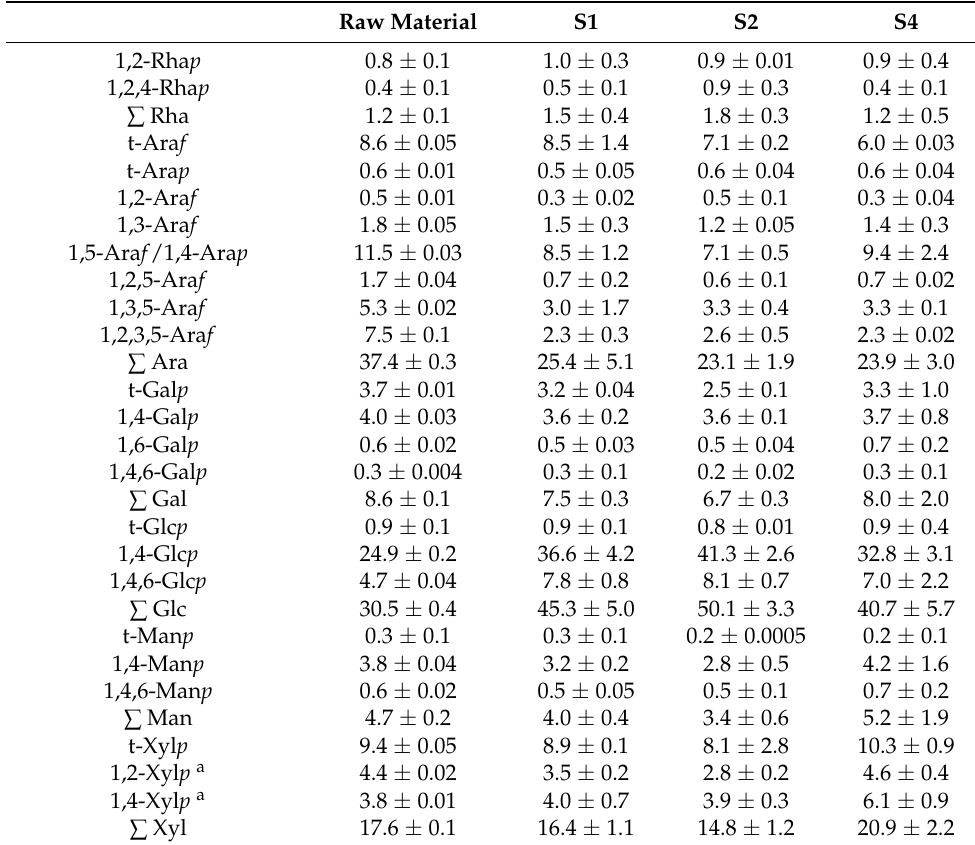
Table 3. Glyosidic linkage of insoluble dietary fiber (IDF) of enzymatically treated apple pomace (raw and extruded) (mol%, mean value ± range/2, n = 2). t: terminal, p: pyranose, f: furanose, Rha: rhamnose, Ara: arabinose, Gal: galactose, Glc: glucose, Man: mannose, Xyl: xylose, S1: